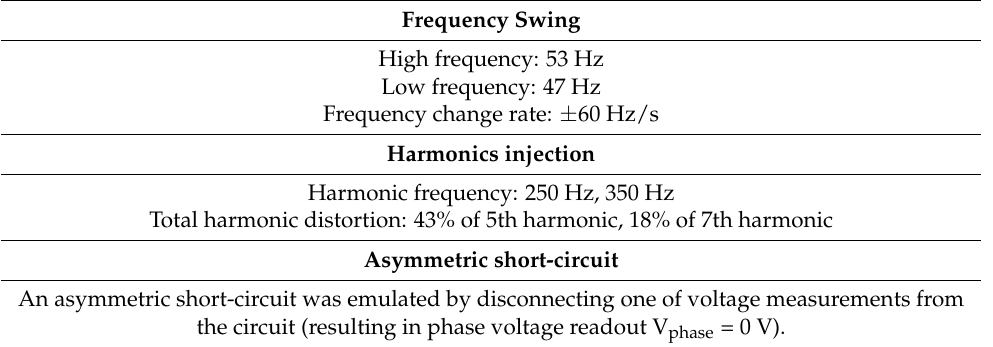
Table A1. Test condition summary.